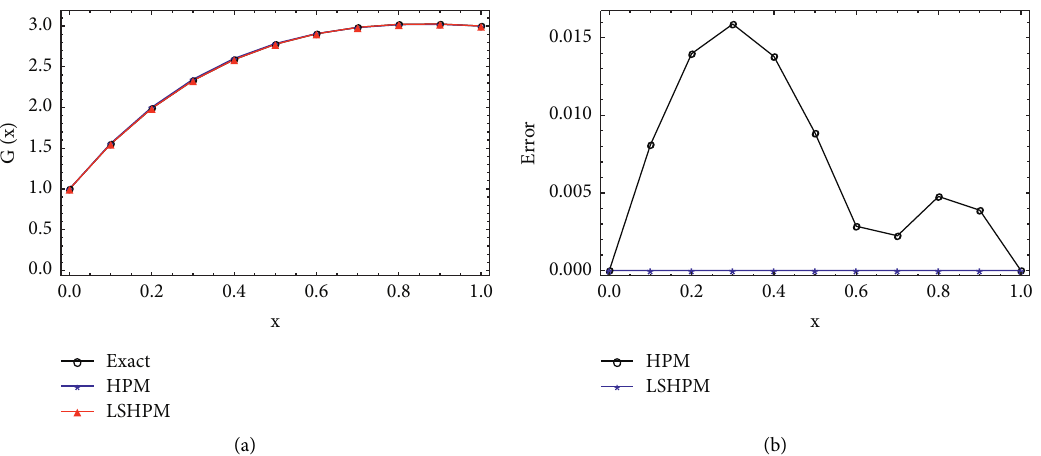
Figure 1: Graphical representation of solutions and errors in Problem 1. (a) Comparison of Exact, HPM, and LSHPM solutions. (b) Comparison of absolute errors of HPM and LSHPM.